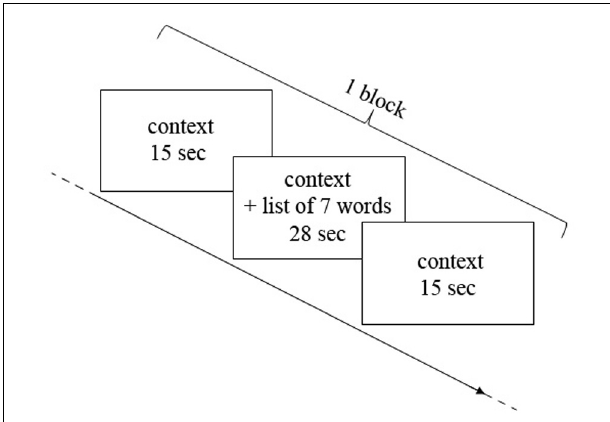
FIGURE 1 | Representation of one block of encoding. Each block consisted in 15 s of context alone (music or silence in the earphones), then 28 s of context and words encoding (seven words for each block, 4 s for each word) and then again 15 s of context